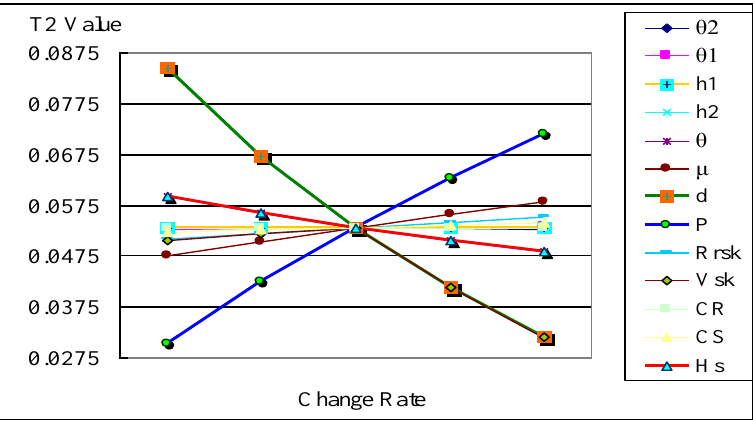
Figure 4. Sensitivity analysis for T 1 when input parameters change.